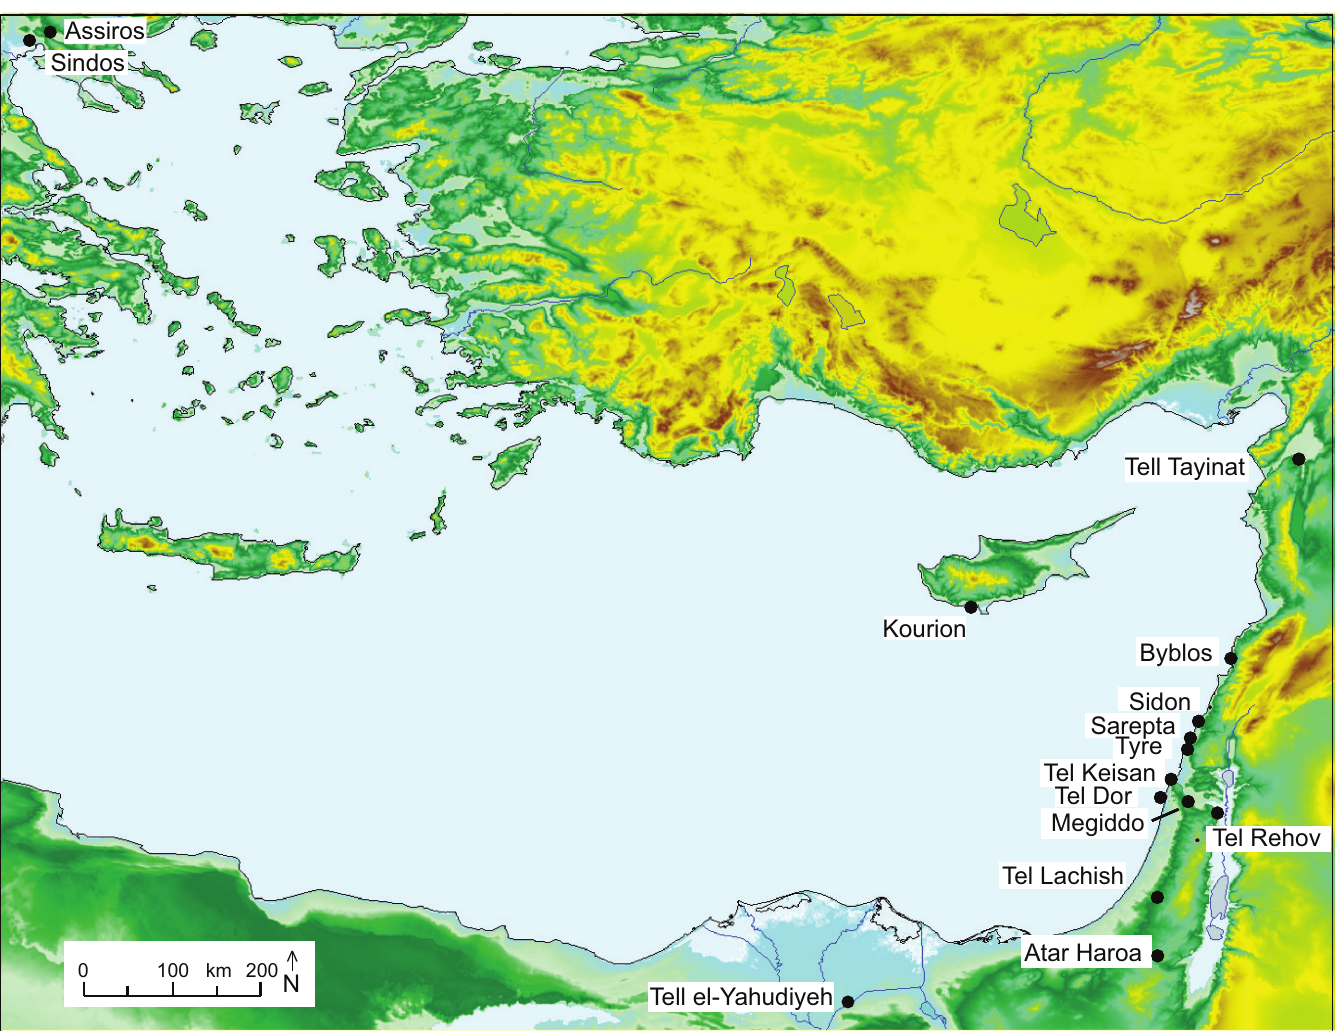
Fig 1. Map showing the Aegean and the eastern Mediterranean with the sites mentioned in the text (Produced by Globalmapper © based on SRTM-30 data with WGS84 projection).